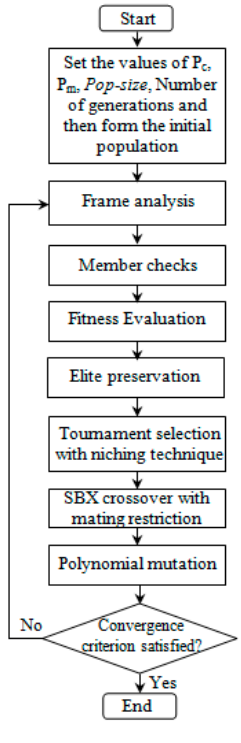
Figure 8. Flowchart of real-coded GA [11].